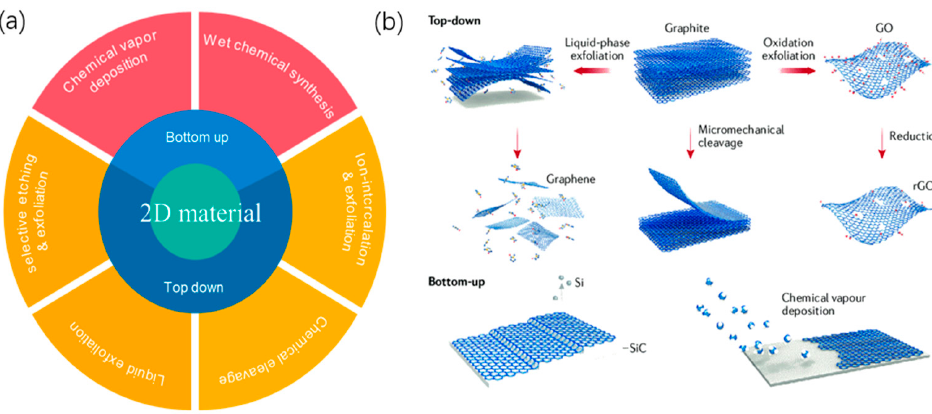
Figure 6. Overview on bottom-up and top-down approach on 2D material fabrication. ( a ) Classifica- tion of fabrication methods of 2D materials; ( b ) Schematic diagram of these two fabrication methods using graphene as an